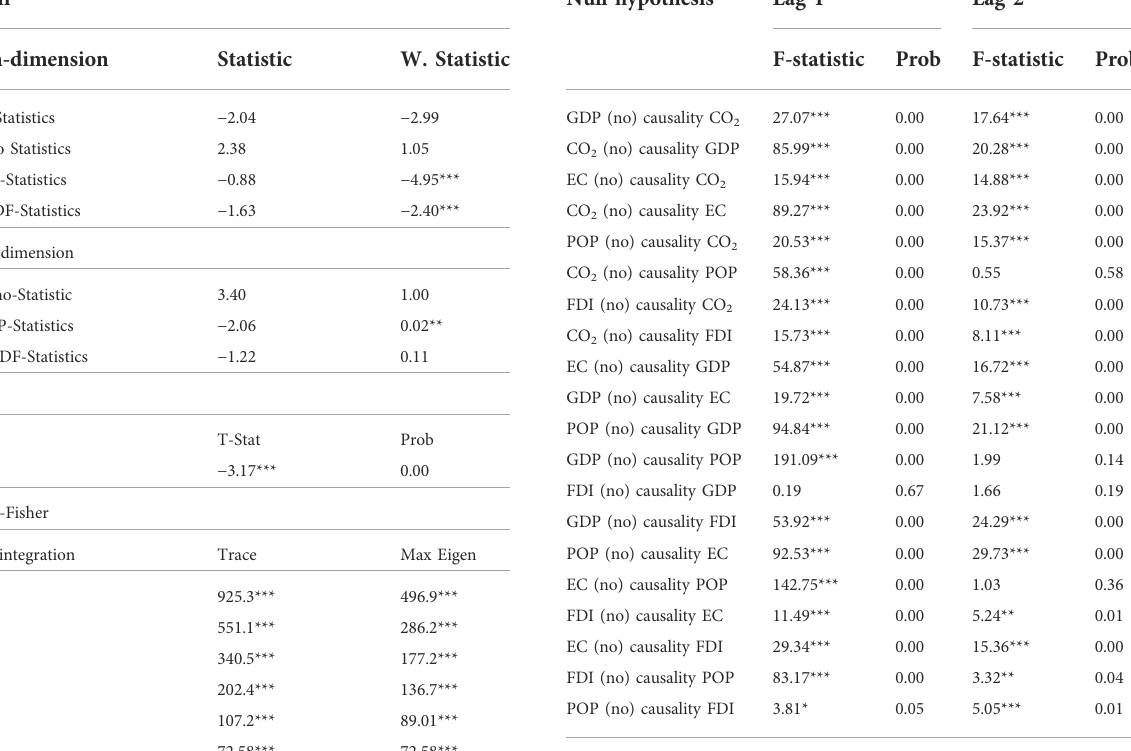
TABLE 7 Results of pair-wise Granger causality tests. TABLE 5 Results of Pedroni, Kao, and Fisher Cointegration analysis.